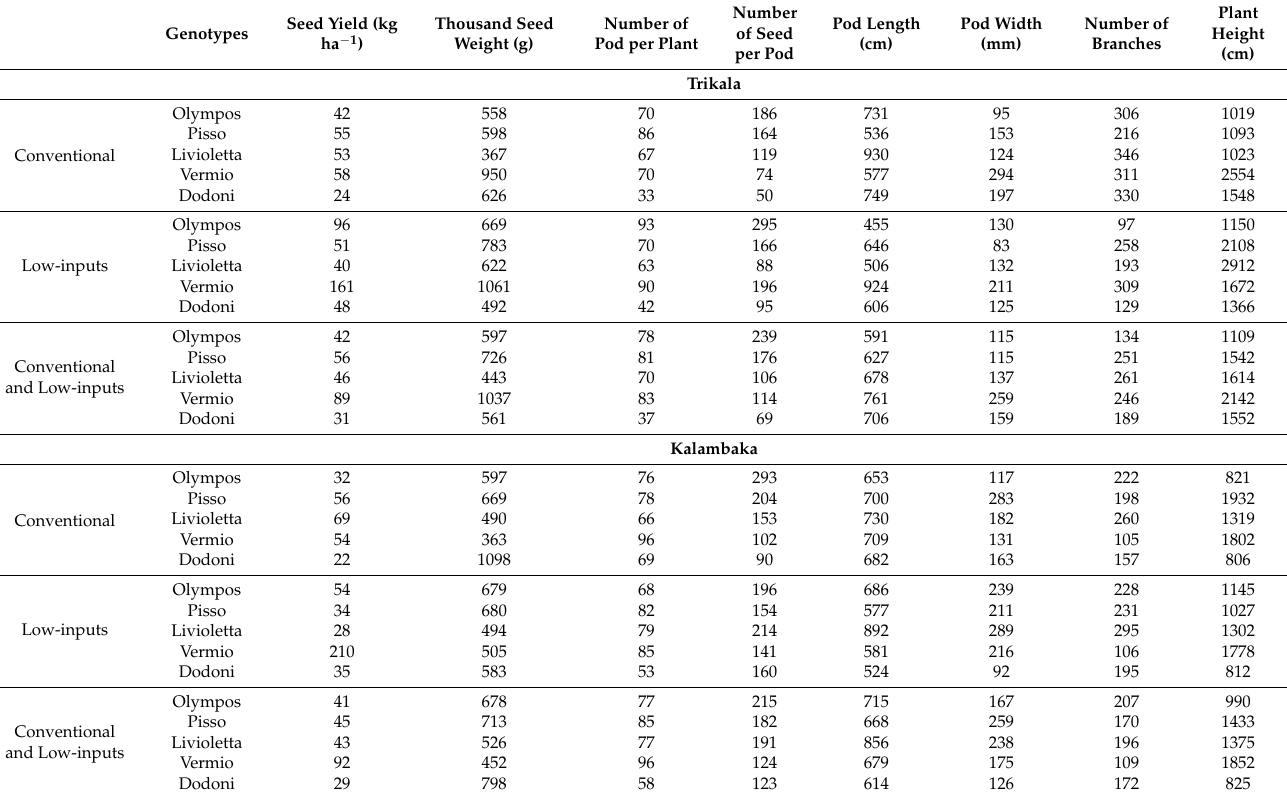
Table 4 combines data for genotypes across environments and farming